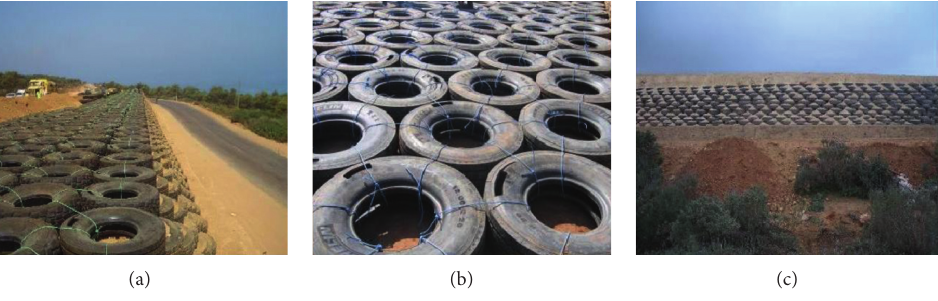
Figure 1: The reinforced applications using scrap